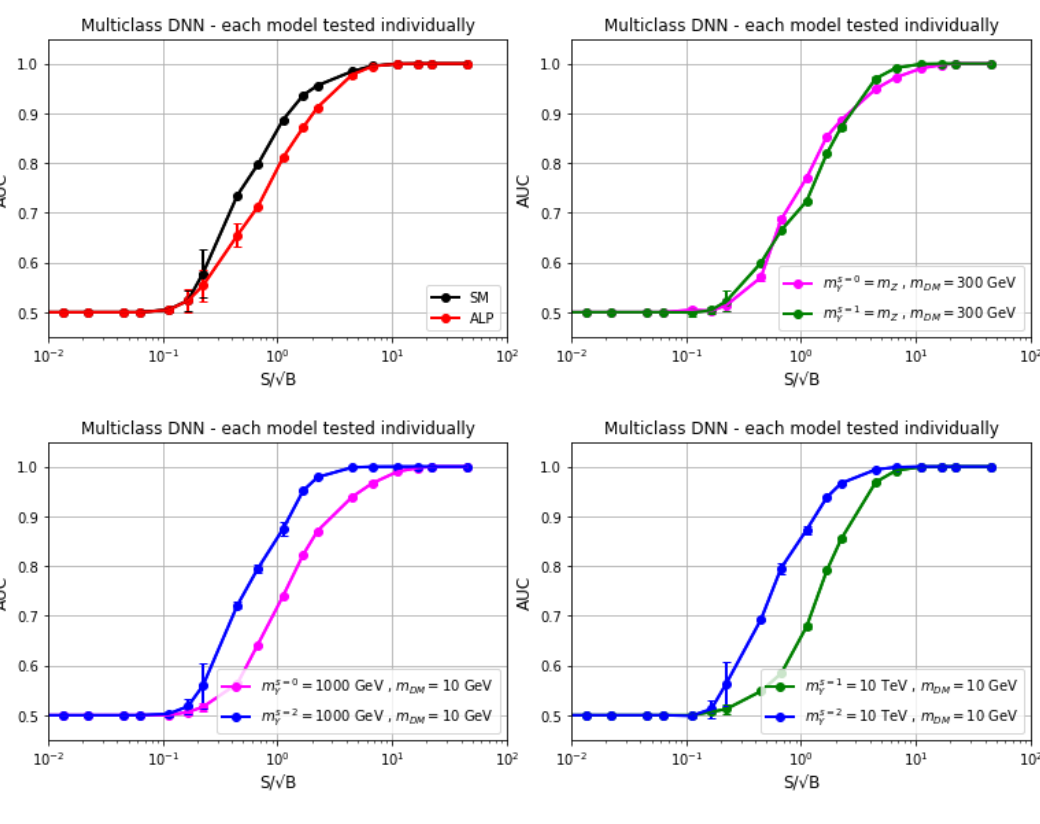
Figure 16: AUCs obtained by applying a test sample of a single model to the multiclass DNN trained with 7 different models and SM-only samples. The multiclass output array is converted into a binary result: we consider the element corresponding to the model we are testing as positive class, while the other elements are taken as negative classes. Error bars are included for all